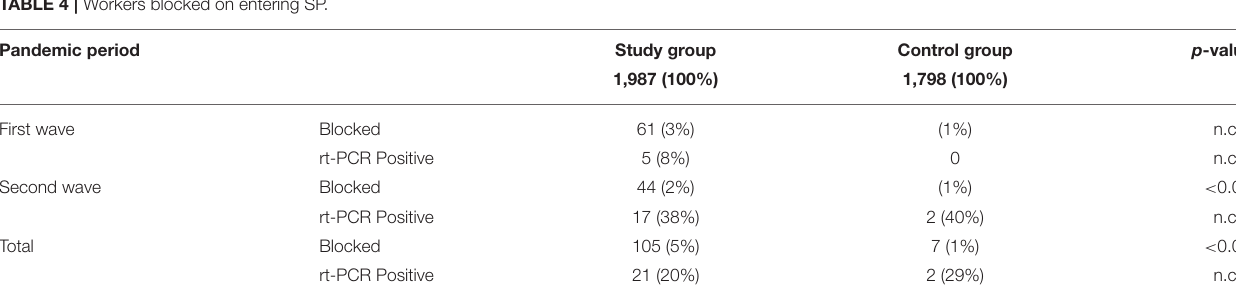
TABLE 4 | Workers blocked on entering